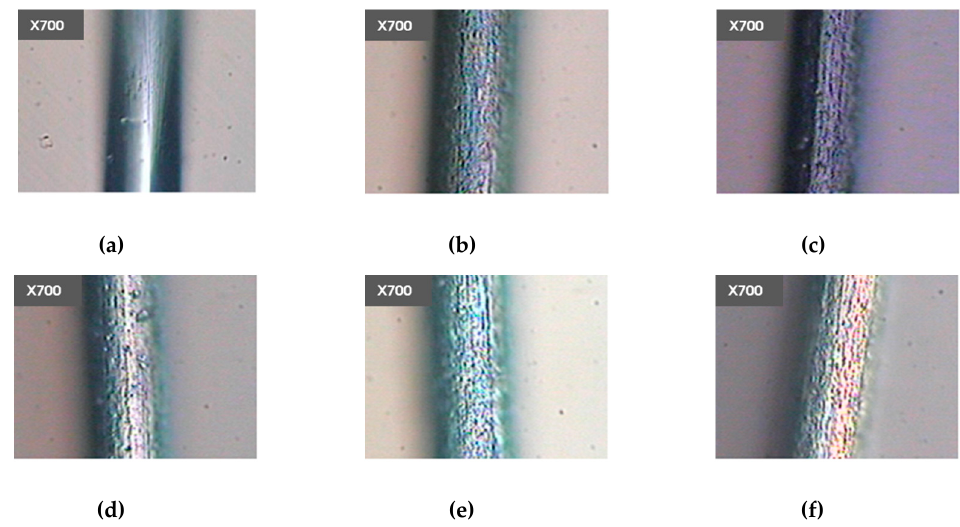
Figure 3. Scanning electron microscopy-energy dispersive X-ray spectrometry (SEM-EDS) analysis of the stainless-steel fiber (a) without the acid treatment and (b) after acid treatemnt.